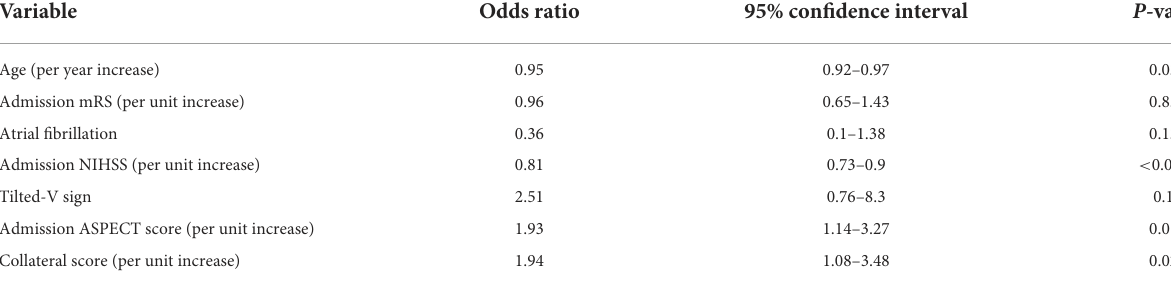
TABLE 4 Characteristics of patients with and without mRS 0–2 upon discharge.